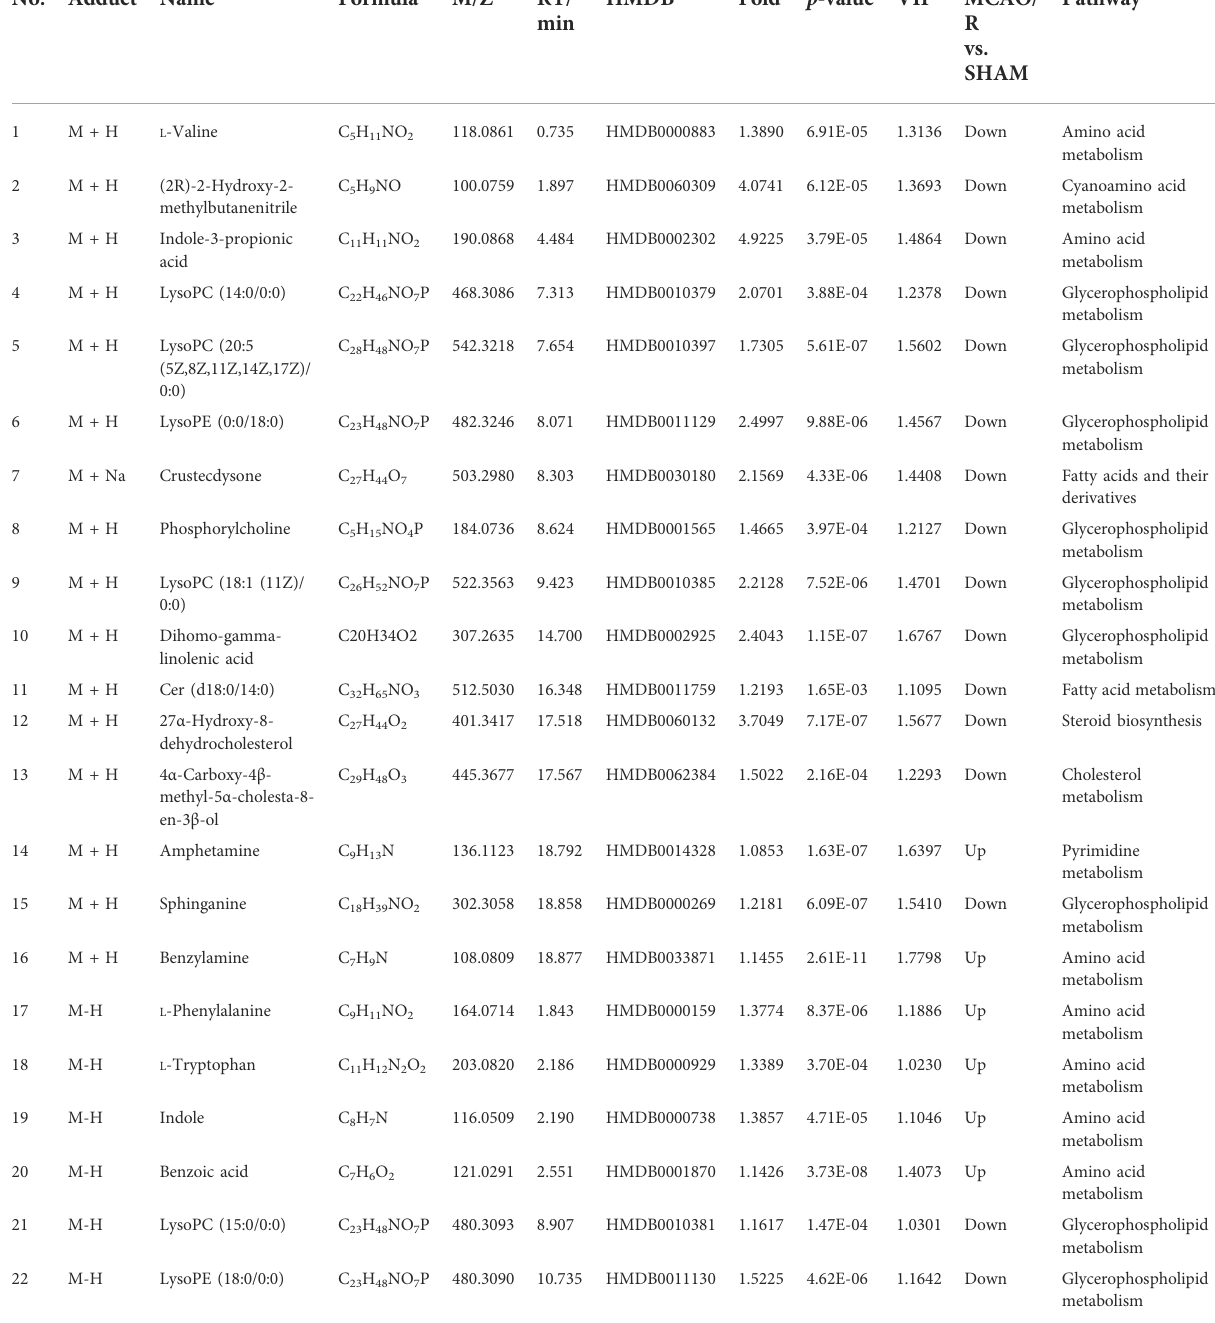
TABLE 1 Statistical analysis results of identi fi ed metabolite changes in